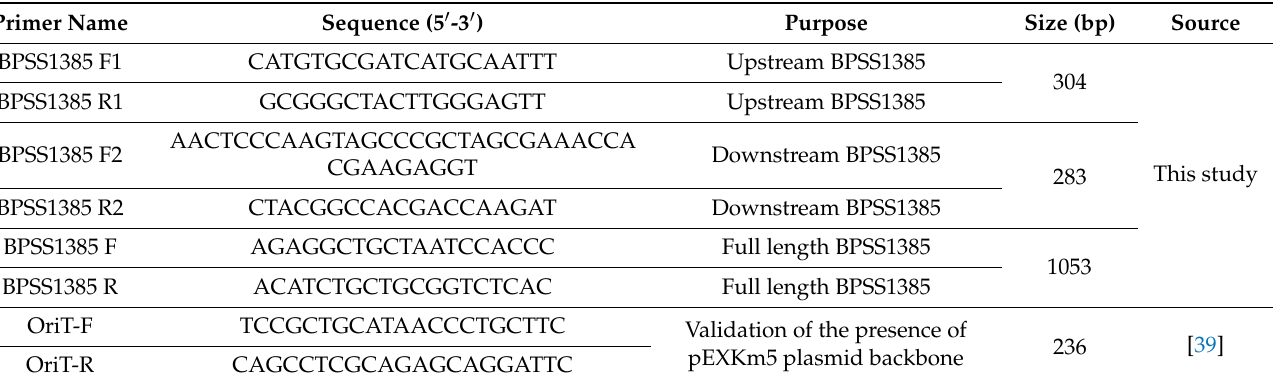
Table 1. Primers used in this